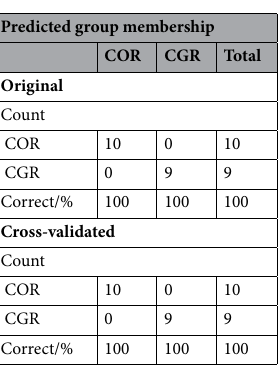
Table 2. Classification of COR and CGR samples based on discriminant